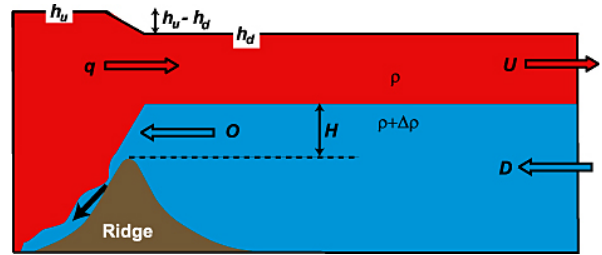
Fig. 14. A two-layer model for the region in the Southern Norwe- gian Sea with IF-inflow, q , FBC-overflow, O , net outflow from the upper layer, U , and inflow of dense water, D